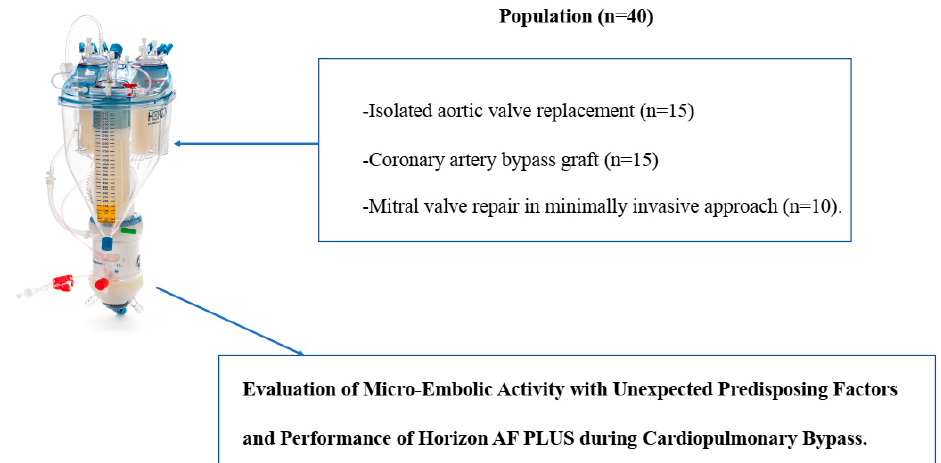
Figure 1. Study population.